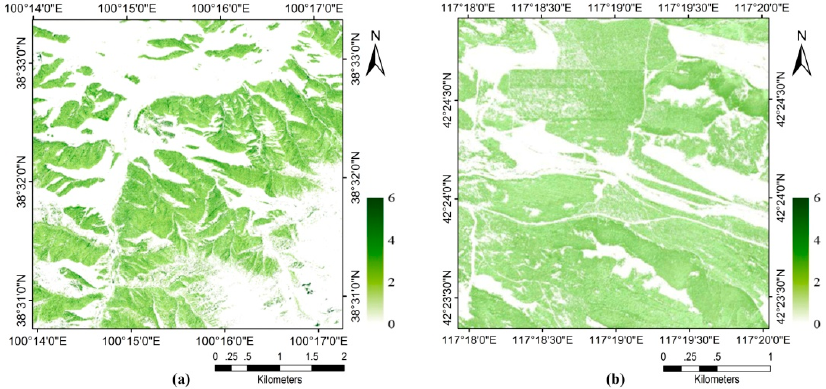
Figure 9. Retrieved effective LAI of the study areas at Dayekou ( a ) and Saihanba ( b ).